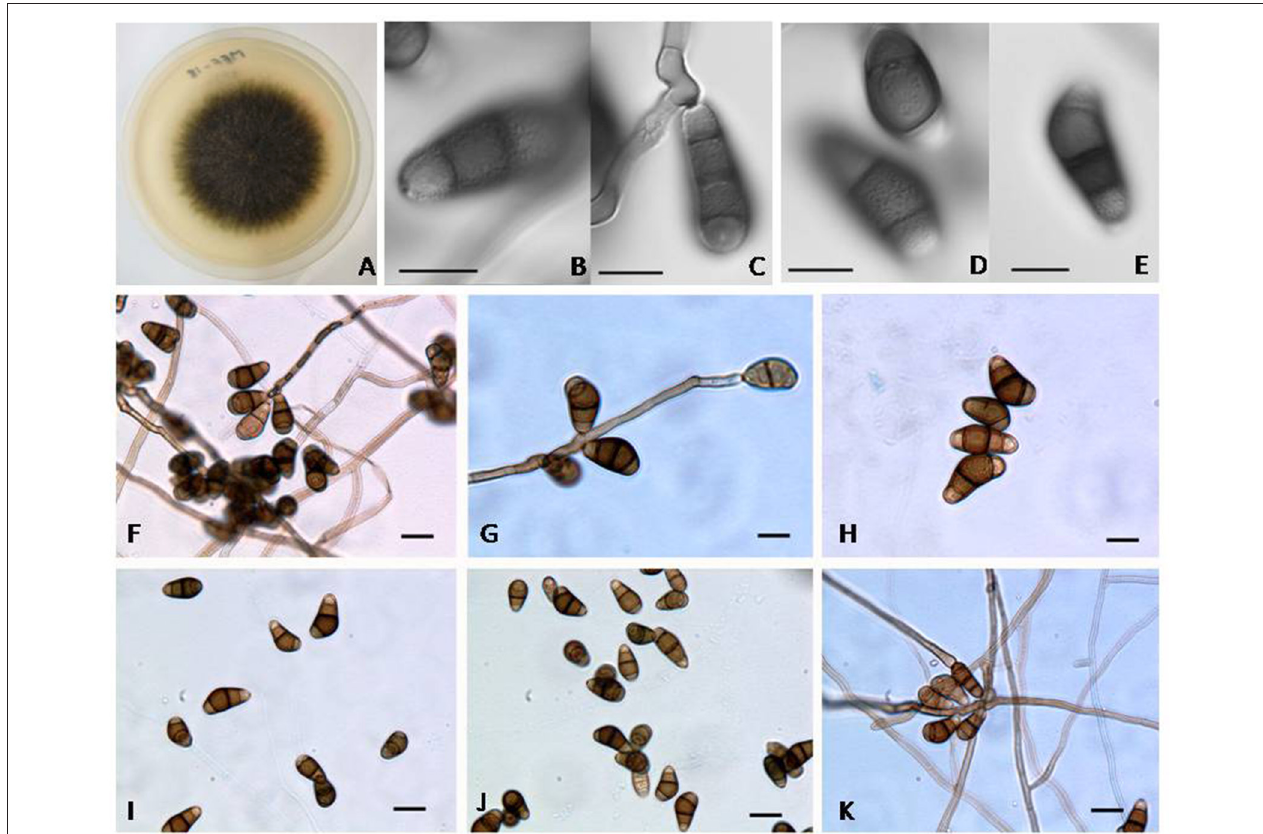
FIGURE 4 | (A) Colony morphology of Curvularia lonarensis strain MEF018 on OA; (B–E) Morphology of conidia as captured by DIC imaging showing ornamentation on all cells of conidia (Scale bars: B–E = 10 µ m); (F–K) Structural features of conidia and conidiophores of Curvularia lonarensis strain MEF018 as depicted during light microscopic imaging. (scale bars: F–K = 20 µ